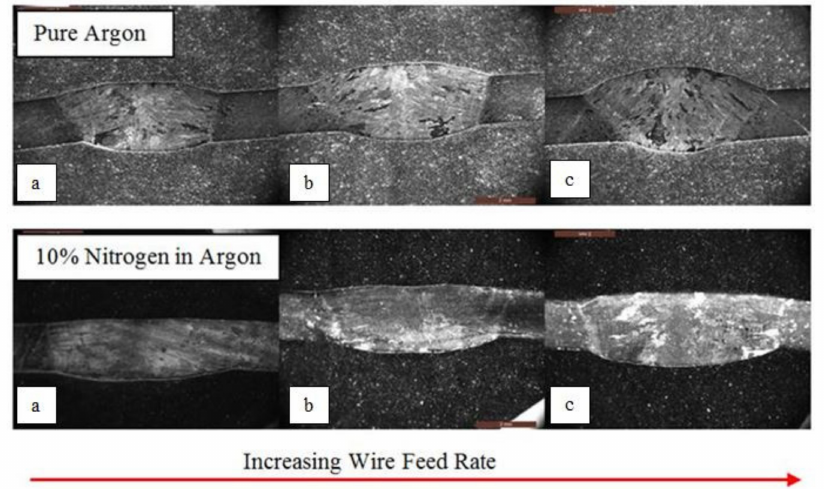
Figure 9. Illustration of the interaction effect between WFR and N 2 in the shielding gas. In the absence of nitrogen, an increase in the WFR decreases the PEN , but in the presence of nitrogen, an increase in WFR increases the PEN .